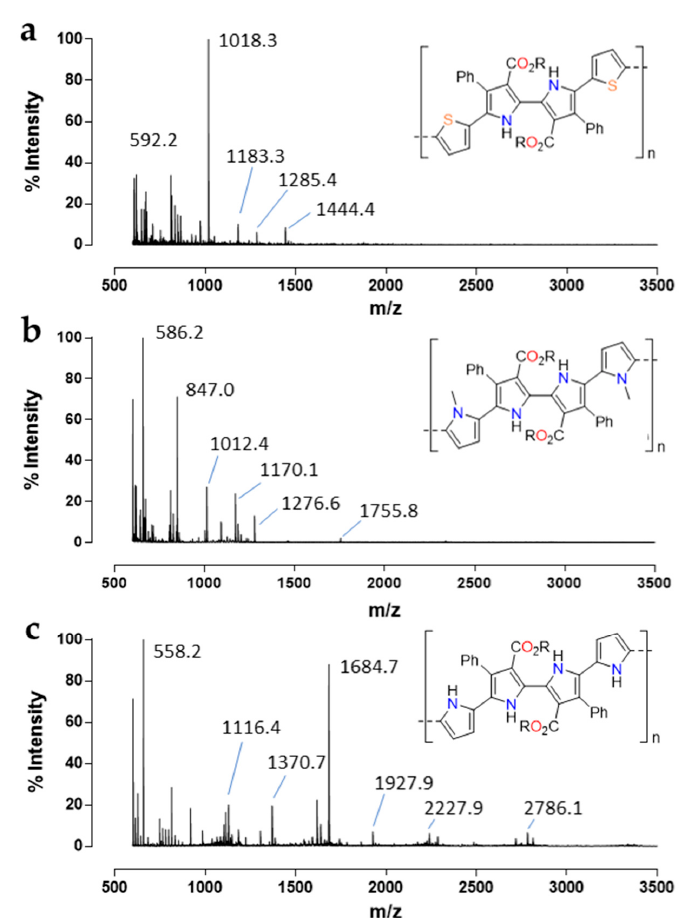
Figure 4. 2,2 (cid:48) -Bipyrrole oligomers in the cyclic voltammetry media after 100 cycles shown by matrix-assisted laser desorption ionization time-of-flight (MALDI-TOF) spectrometry: 1c ( a ) and quaterpyrroles 1a and 1b ( b , c ) (R = Et).